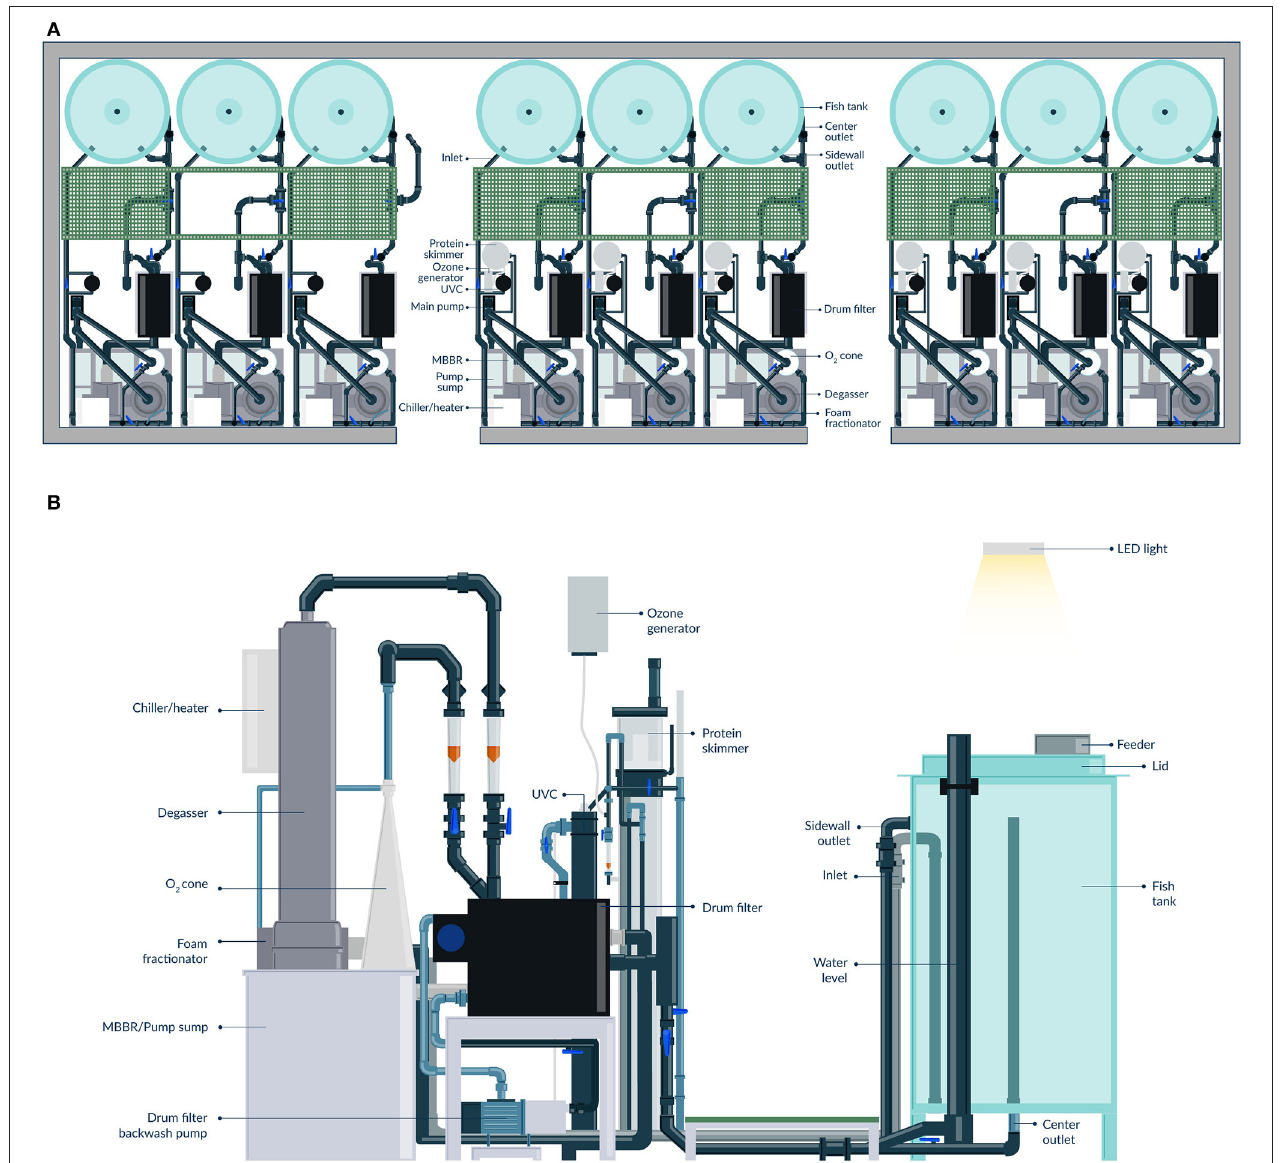
FIGURE 1 | Sketch of the RAS research facility (A) and of a replicated RAS unit (B) .